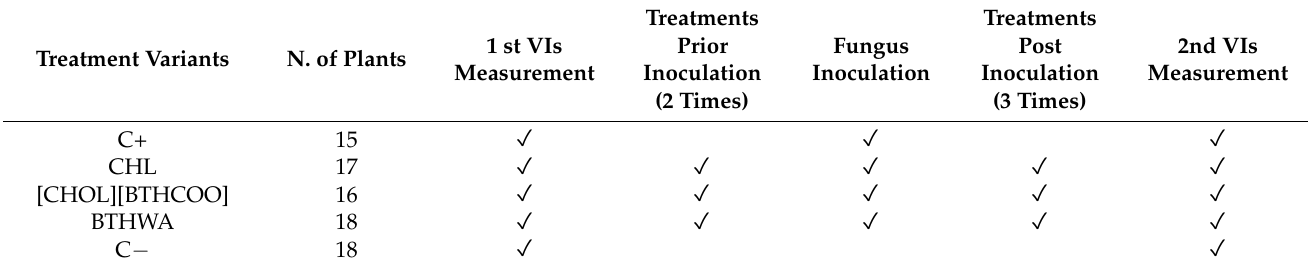
Vegetation indices (VIs) measured: Normalized Difference Vegetation Index (NDVI), Simple Ratio Index (SR).